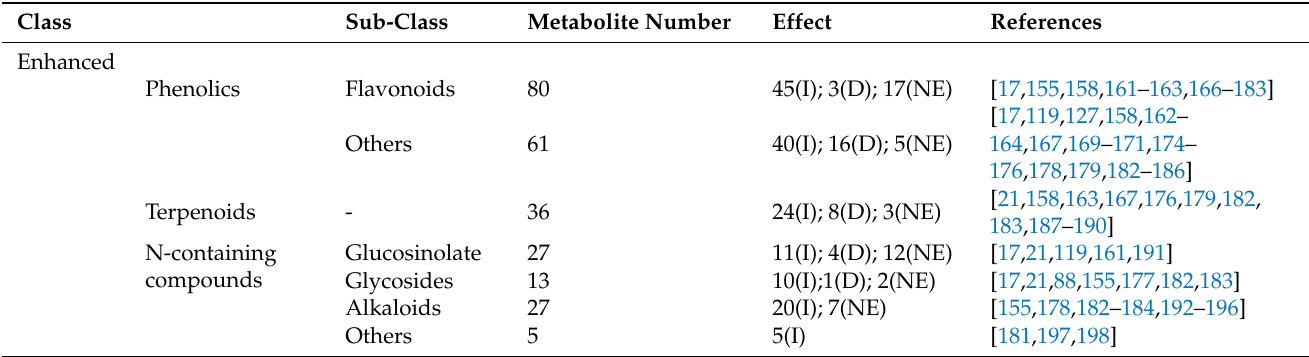
Table 5. Effects of ultraviolet-B radiation on plant secondary